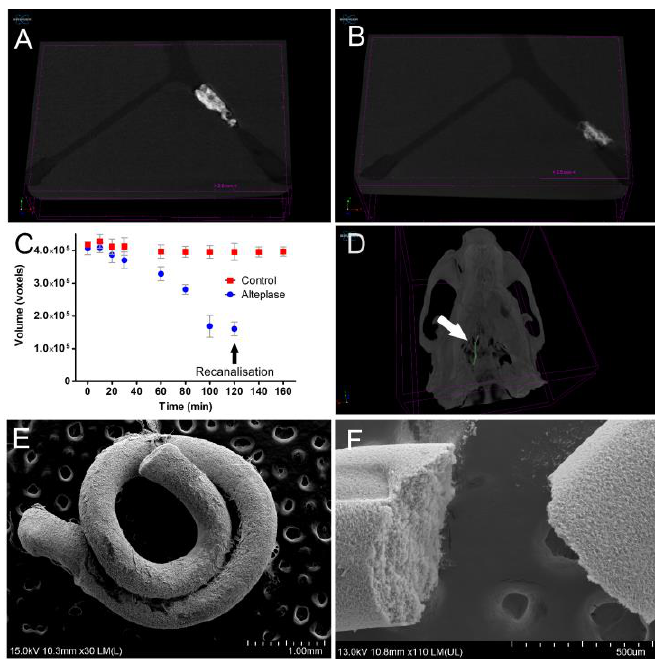
Figure 6. Re-canalization of the MCA model observed using microCT. Barium sulphate was used as a contrast agent for visualization of the thrombus in the MCA model. Visualization of the thrombus at time zero ( A ), and after recombinant tissue plasminogen activator (rtPA) treatment at 120 min ( B ). The volume of the thrombus as a function of time during 160 min time interval after rtPA treatment analyzed by GraphPad Prism from microCT pictures: a negative control (red square), rtPA treated (blue circle) ( C ). Proof-of-concept of barium sulphate thrombus labelling under in vitro conditions. The experiment demonstrated the application of microCT for both in vitro and in vivo barium sulphate-labelled thrombus imaging; thus, serving for precise in vitro and in vivo thrombolysis monitoring. The rat’s brain artery at time zero was visualized using pre-labelled thrombus ( D ). SEM image of pre-labelled thrombus prepared using the TISSEEL kit applied to rat brain ( E ). Detail of the structure of fibrin thrombus ( F ).